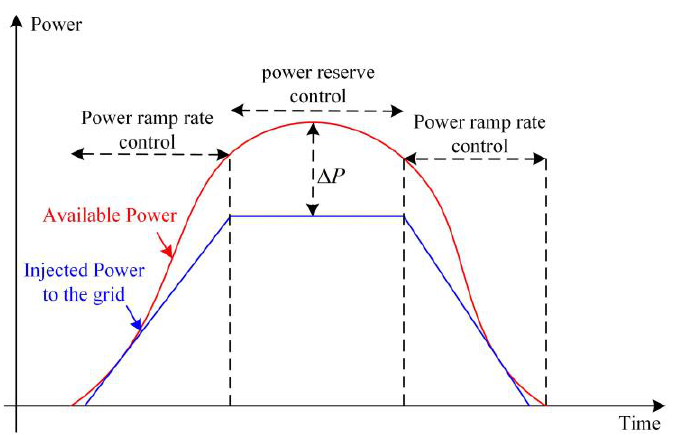
Figure 5. Active power (AP) curtailement.